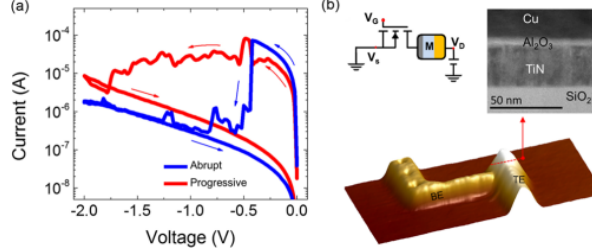
Figure 6: (a) Two different RESET mechanism are observed in similar devices operated under identical conditions. In the red trace, during the process of transfer to HRS the current decreases progressively corresponding to a lower value (HRS). The blue trace exhibits a steep reduction of the current at − 0.5 V leading the device to HRS. No difference in forming and SET voltage are observed and they are not shown. The final obtained resistive states are comparable for both devices. (b) Schematic of the one-transistor-one-resistor configuration. Details of the cross-point cell are shown with AFM to- pography (2 × 0.9 µ m scan size) and cross-sectional TEM.